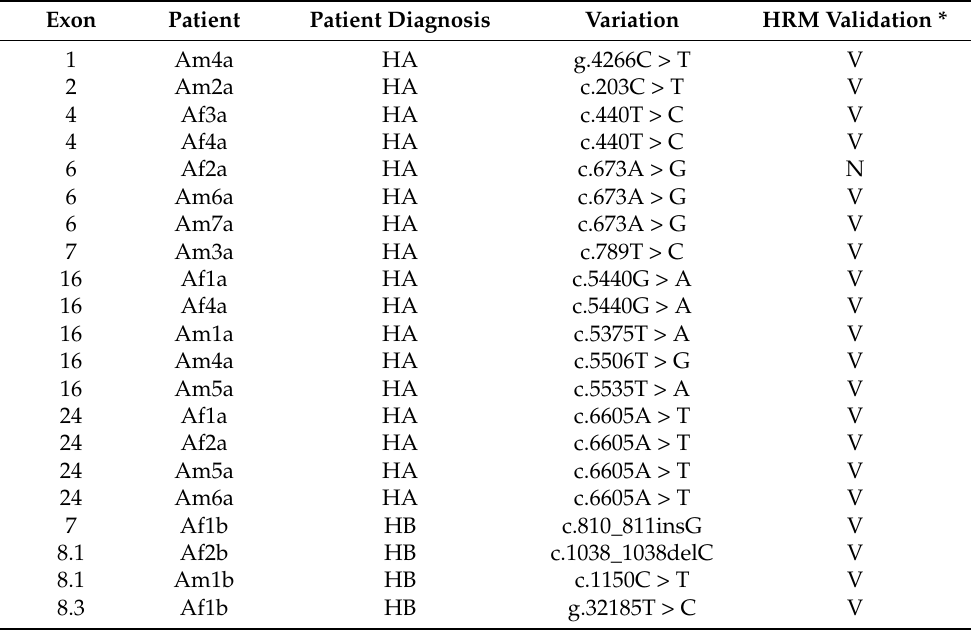
Figure 3. HRM technique validation results. In green wildtype, genotype samples, and in red, T > C genotype samples. ( A ) Amplification plot. ( B ) Normalized melting curves. ( C ) Normalized melting peaks. ( D ) Difference plot. Table 4. HRM analysis results for exons of the F8 and F9